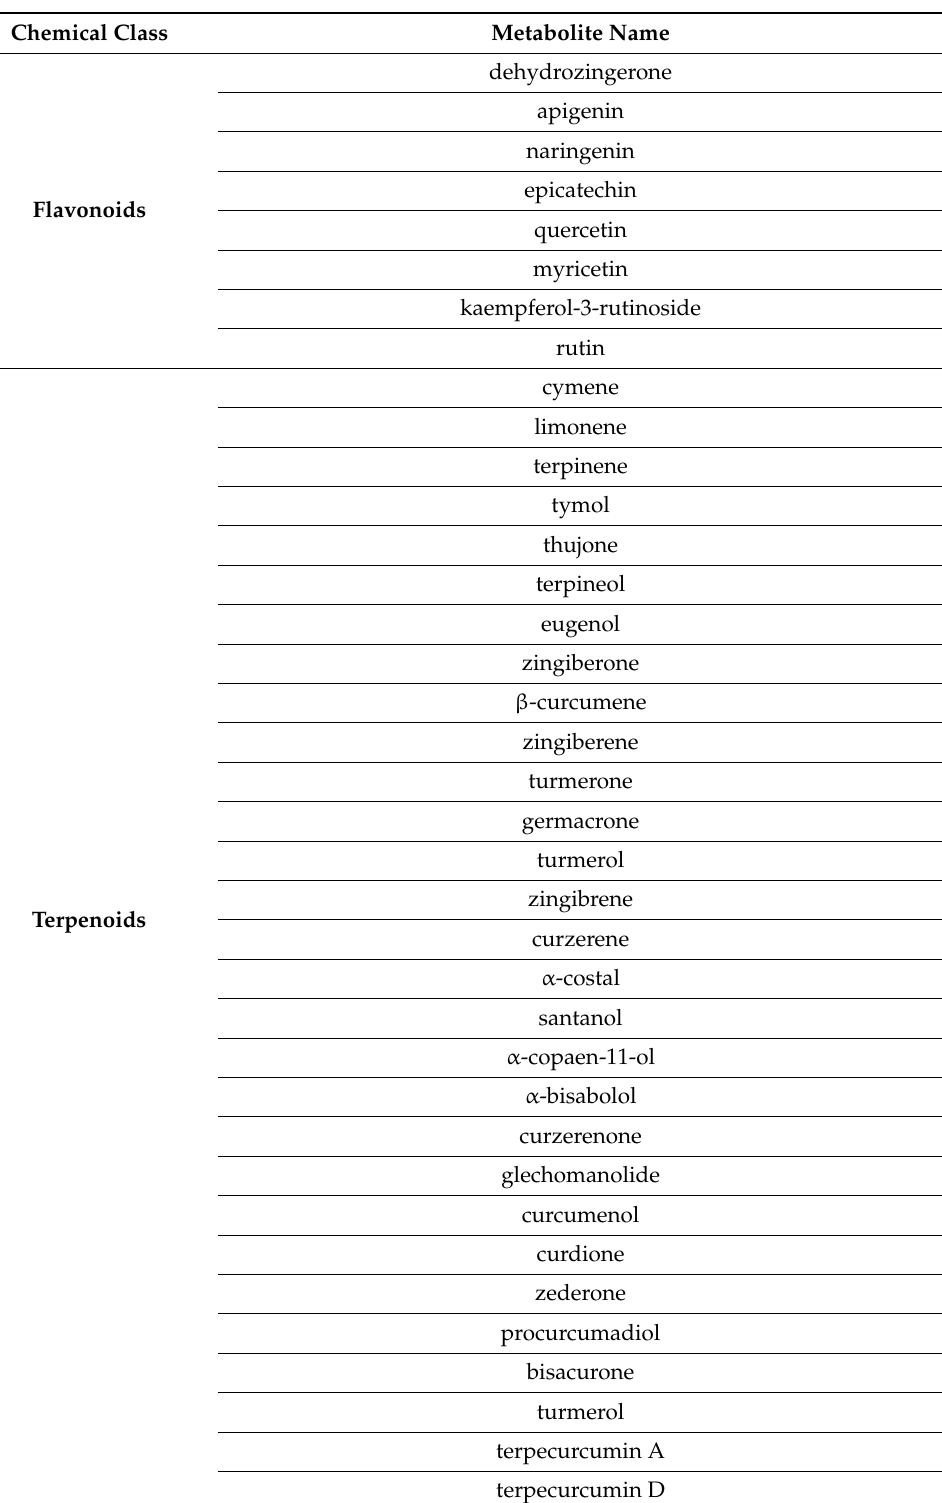
Table 3. Classification of bioactive phytoconstituents from the Curcuma longa sample organized according to chemical